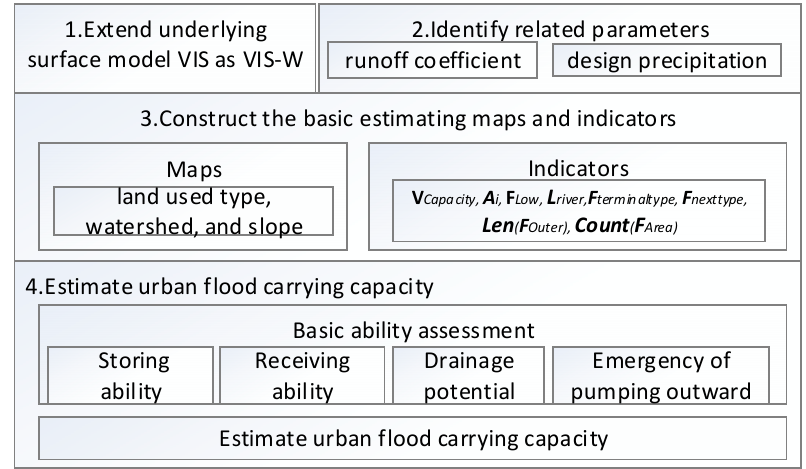
Figure 2. The urban flood-carrying capacity assessment process is made up of four steps. First, we extended the underlying surface model; second, we identified the parameters; third, we constructed the basic estimating maps and indicators; and finally, we estimated the urban flood- carrying capacity.